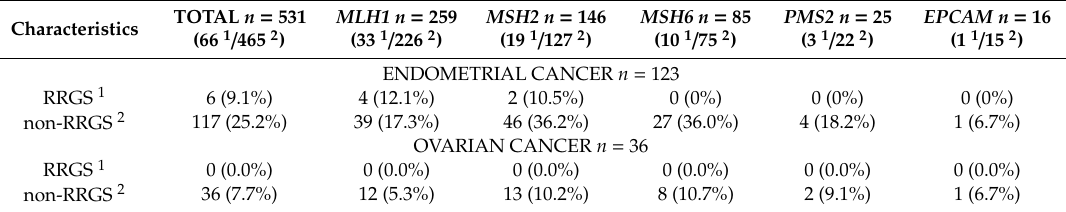
Table 5. Number of gynecological cancer according to mutated genes and type of surgery performed in all LS women.